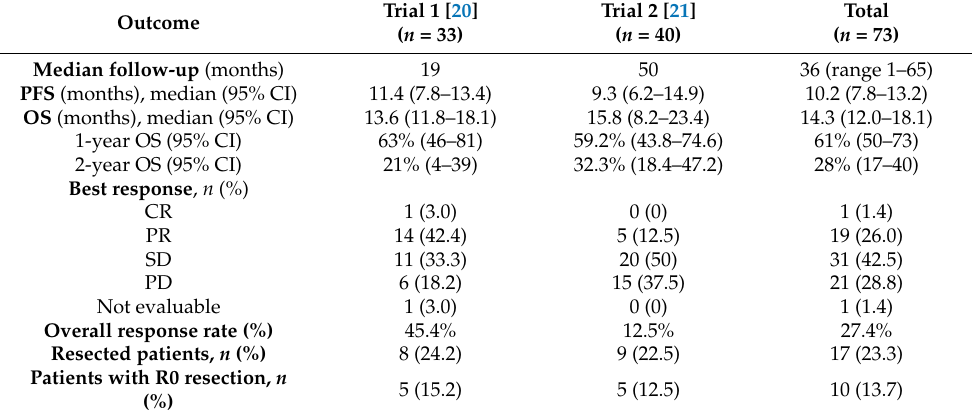
Table 3. Efficacy